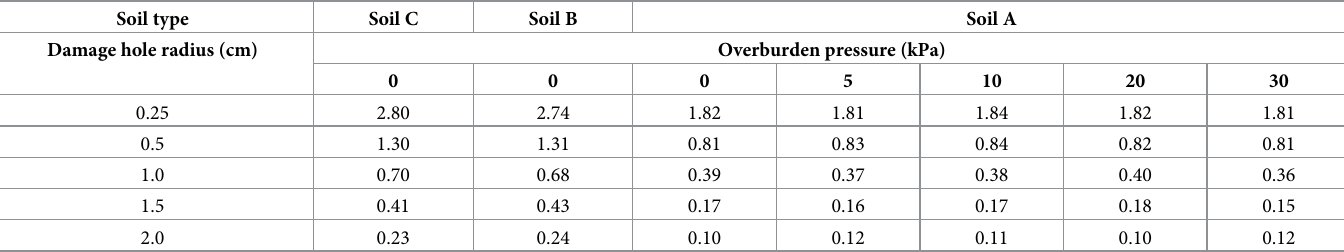
Table 2. Critical gradient of each group.